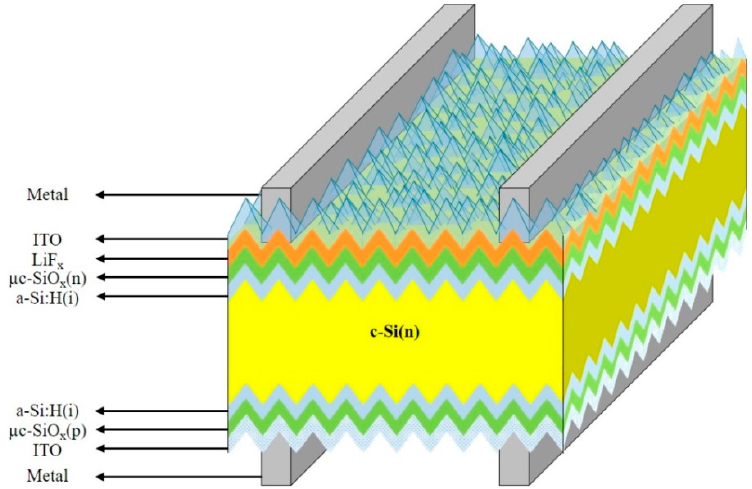
Figure 1. Schematic diagram of the silicon heterojunction SHJ(SHJ) solar cell with lithium fluoride (LiF x ) as an electron selective carrier layer. Table 1. Simulation parameters for LiF x and various silicon layers in an electron-based carrier selective contact (CSC) solar cell.